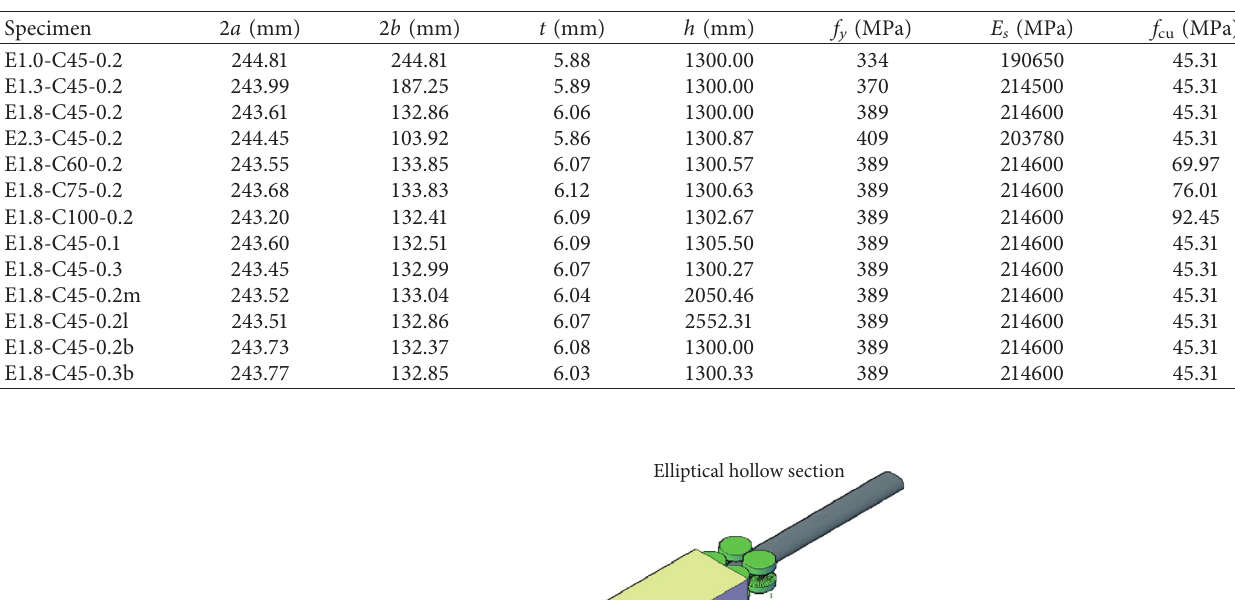
Figure 2: Details of the specimens. Table 1: Measured information of the specimens.